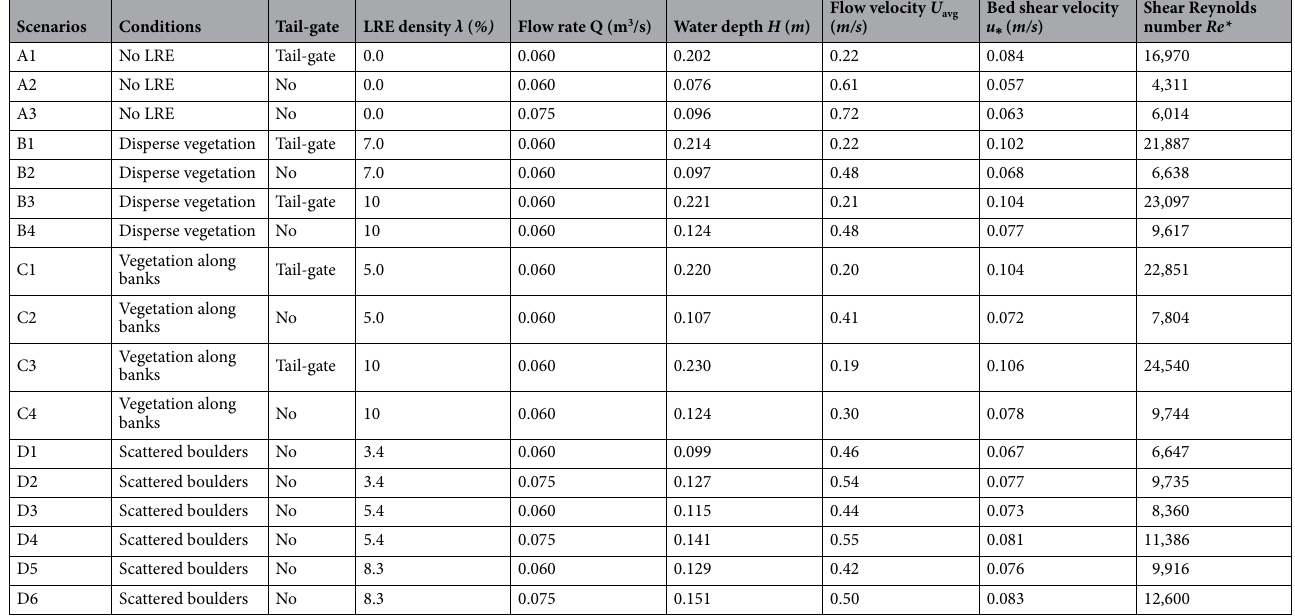
Table 1. Summary of the experimental